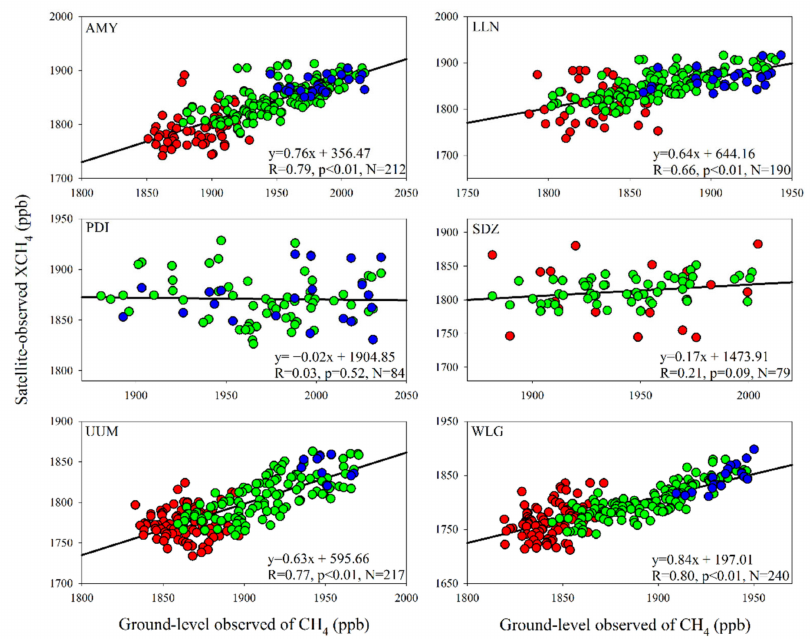
Figure 1. Scatter plots of satellite-observed XCH 4 concentrations and ground-level observations of CH 4 concentrations; red: SCIAMACHY, green: GOSAT, blue: